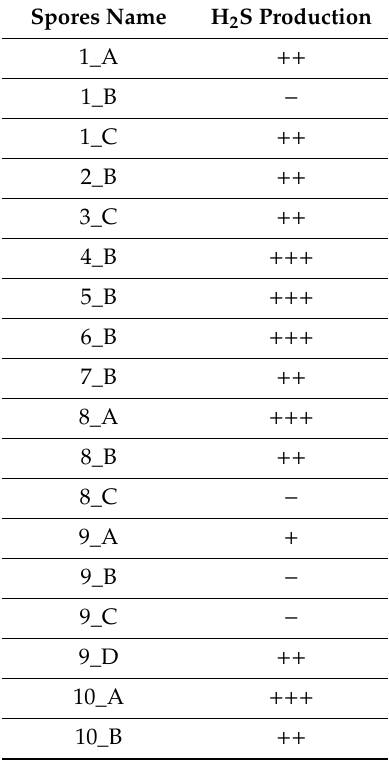
Table 1. H 2 S production of the viable spores.